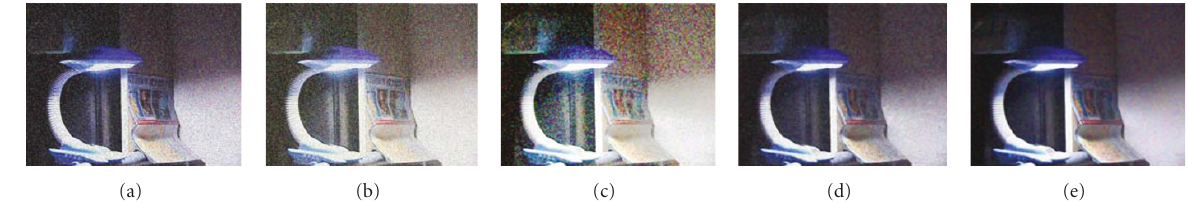
Figure 10: Overexposed video results. (a) Test video added by mixed impulse ( p = 10%) and Gaussian ( σ = 10) noise. (b) Result of histogram equalization. (c) Result of AML3D filter followed by histogram equalization. (d) Result of AML3D filter followed by our APMF. (e) Result of our